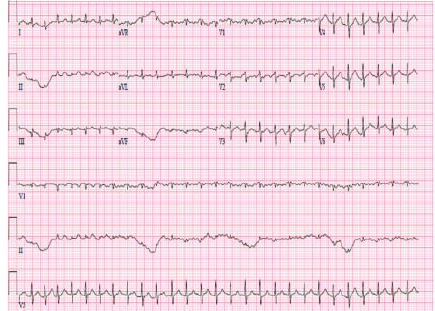
Figure 2: EKG revealing sinus tachycardia with no evidence of pericardial disease.